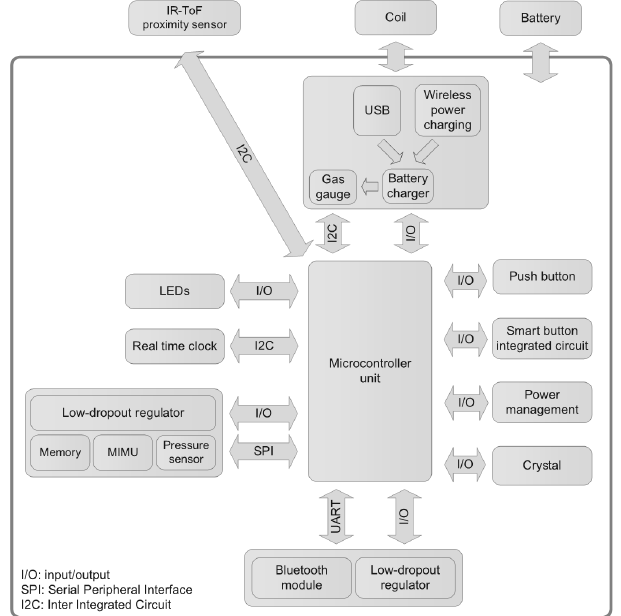
Figure 1. Block diagram of the D-MuSe. The system consists of an ultra-low-power core ( STM32F4 ) and low-power sensors with an advanced power management architecture. The radio frequency communication is provided by a Bluetooth module ( BT33 provided by Amp’ed RF/STMicroelectronics, San Jose, CA, USA